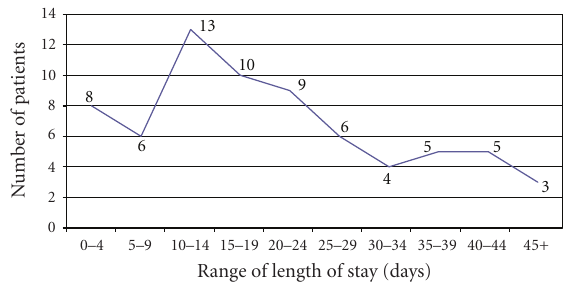
Figure 3: Length of hospital